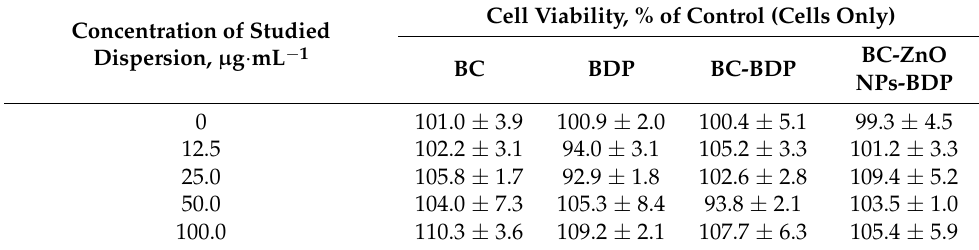
Table 7. Cell viability under the action of dispersions of studied wound dressings (BC-BDP, BC-ZnO NPs-BDP) and BDP ( n = 3, p < 0.01).